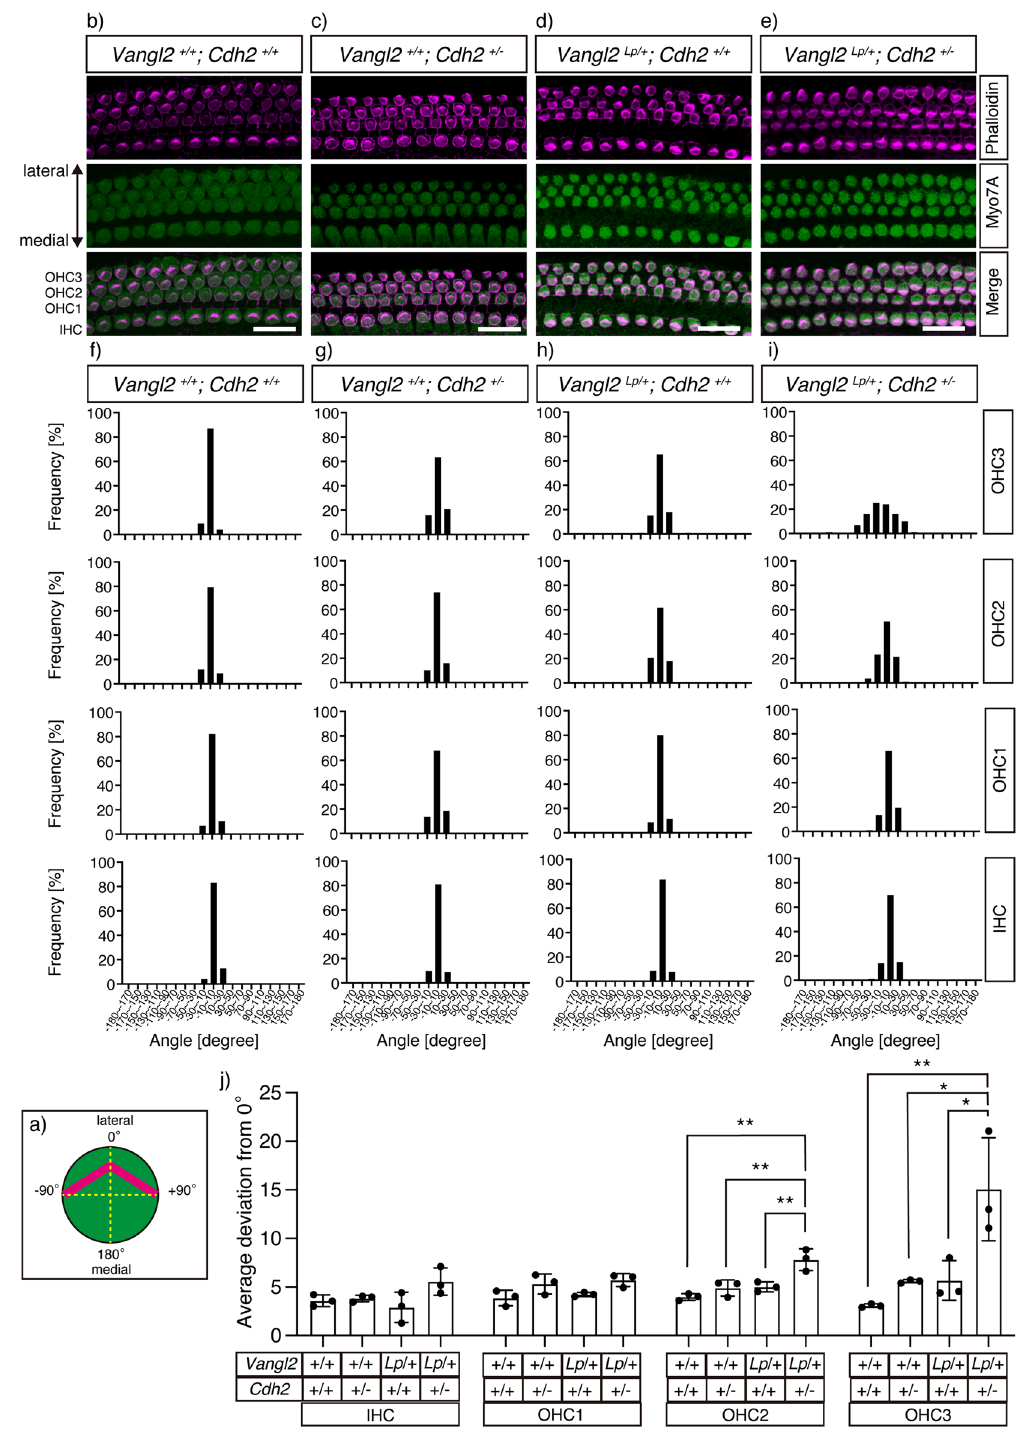
Figure 6. Genetic interaction between Cdh2 and Vangl2 in inner ear. ( a ) A diagram showing an example of a hair cell, whose bundle orientation is 0°. The depicted angles (-90°, 0°, + 90°, + 180°) were used as the standards to analyze the orientation of the stereociliary bundle of each hair cell. ( b–e ) Fluorescence images of the sensory epithelia in the E18.5 inner ear with the indicated genotypes. The stereociliary bundles were stained with phalloidin (magenta) and cochlear hair cells with antibodies against the hair cell marker Myo7A (green). ( f–i ) Bar graphs showing the frequency of stereocilia oriented toward given angle ranges. The patterns of angle distributions of four types of hair cells consisting of the sensory epithelia with the four genotypes are presented: ( f ) wild type, ( g ) Vangl2 + / + ; Cdh2 + /- , ( h ) Vangl2 Lp/ + ; Cdh2 + / + , and ( i ) Vangl2 Lp/ + ; Cdh2 + /- . ( j ) Bar graphs showing the average deviation of the angles of the stereocilia measured from 0°. The results of four types of hair cells derived from the four genotypes are presented. Note that the digenic mutants exhibit cumulative increase of angle deviation of the bundle orientation in OHC2 and OHC3. For each bar graph, more than 100 hair cells were subjected to the analysis (different litters, n = 3). Significant differences between groups that were calculated using Tukey’s multiple comparison test are marked with * (p < 0.05) or ** (p < 0.01). Scale bars: 20